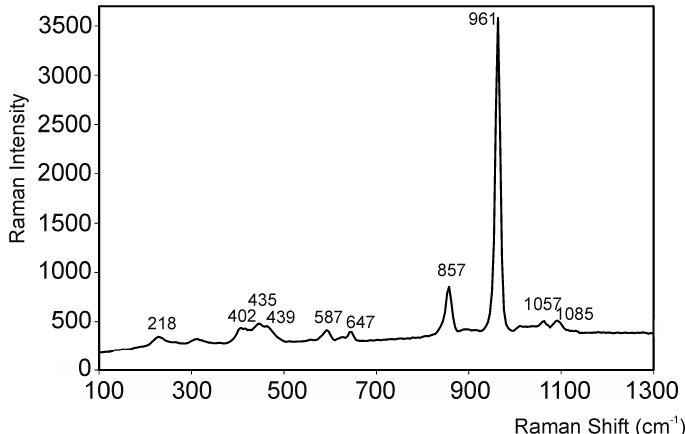
Figure 4. Raman spectra of Nurse’s A ceramic.